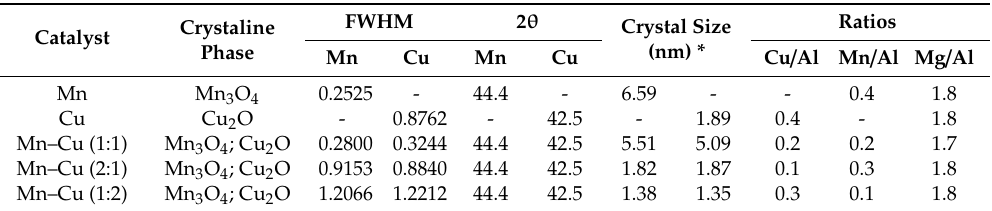
Table 2. Particle size of the mixed solids, according to the crystalline phase determined from the XRD signals. Ratios determined by XRF.